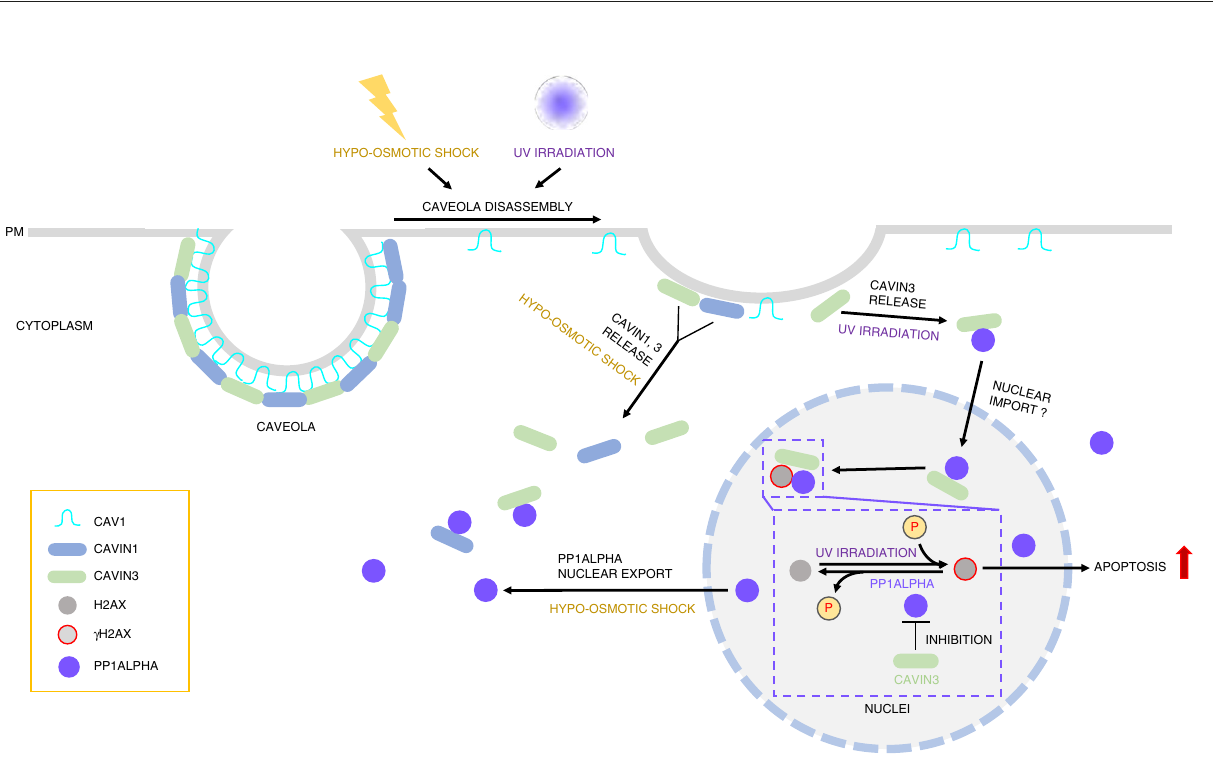
Fig. 6 γ H2AX coprecipitates with PP1 α and Cavin3 following UV stress. a A431 cells were treated with tautomycin (0.5 μ M) for 3 h prior to UV irradiation. After a 4 h chase, cells extracts were western blotted for γ H2AX and H2AX levels. β -Actin was blotted as the loading control. b γ H2AX expression levels were quanti fi ed from three independent experiments where the data is presented as mean ± SD. Unt ( − TTM): 100.0 ± 0.0%; Unt ( + TTM): 155.1 ± 10.7%; UV ( − TTM): 108.8 ± 31.5%; UV ( + TTM): 215.2 ± 30.1%) where * p = 0.0466 was calculated using an ordinary one-way ANOVA. c , d GFP Trap assays of A431 cells transfected with GFP-PP1 α or GFP ( c ), GFP-Cavin3 or GFP ( d ) followed by western bloting with an anti- γ H2AX antibodies. Transfection ef fi ciency was con fi rmed with GFP antibodies. α -Tubulin was used as the loading control. e , g PLA of the interaction of endogenous PP1 α ( e ) or Cavin3 ( g ) with γ H2AX upon UV radiation (shown as red dots). PLA signals alone were inverted to gray scale. Scale bar, 10 μ m. Mean ± SD from three independent experiments are presented on the images. f , h The number and ratio of the PLA signals for PP1 α ( f ) or Cavin3 ( h ) with γ H2AX in the cytoplasm (gray) and nucleus (purple) were calculated and presented in the histograms and tables as mean ± SD from three independent experiments. i Phosphatase activity of PP1 α in MCF-7 cells with or without mScarlet-PP1 α (mS- PP1 α ) or/and pCB6-Cavin3 transfection. Relative phosphatase activity of control (%) (Ctrl: 100.0 ± 0.0%; mS-PP1: 123.4 ± 8.3%; Cavin3: 77.6 ± 10.0%; mS-PP1 + Cavin3: 93.5 ± 7.4%) is presented as the mean ± SD from three independent experiments (Ctrl vs mS-PP1: * p = 0.0209, Ctrl vs Cavin3: * p = 0.0260, mS-PP1 vs mS-PP1 + Cavin3: ** p = 0.0053) using an ordinary one-way ANOVA